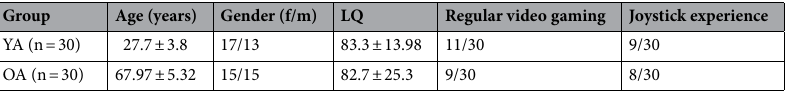
Table 1. Sample characteristics. Age groups did not differ regarding their laterality quotient (LQ), independent-samples t-test: t(45.21) = 0.12, p = 0.91), the amount of regular video gamers (Chi-square test: χ 2 (1) = 0.07, p = 0.79) and the amount of people with joystick experience (Chi-square test: χ 2 (1) = 0.08, p =